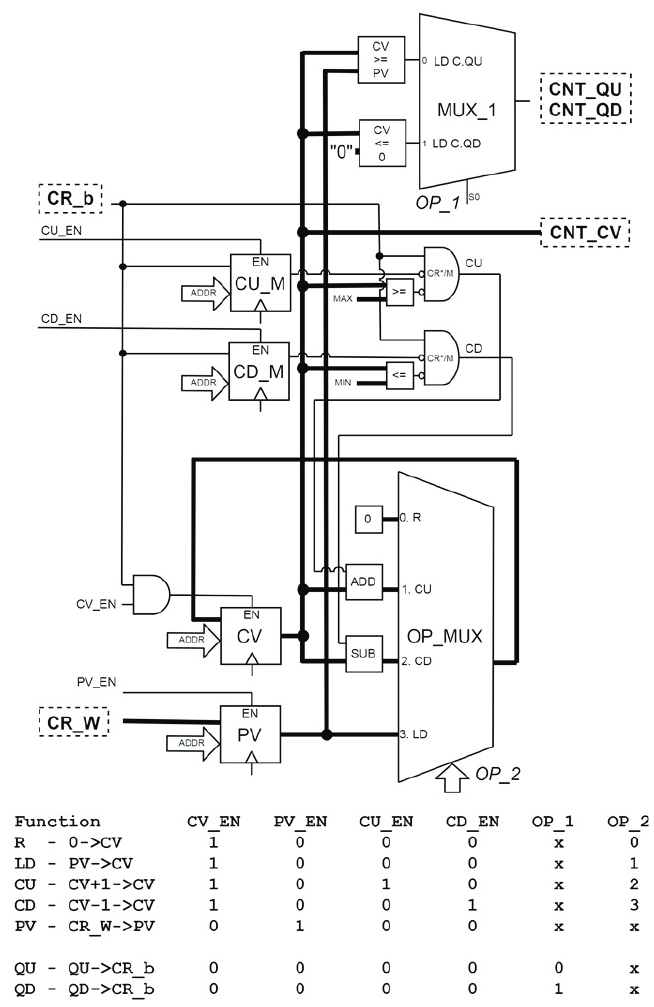
Figure 12. The structure of soft-like counters block dedicated for short operators (CAL not